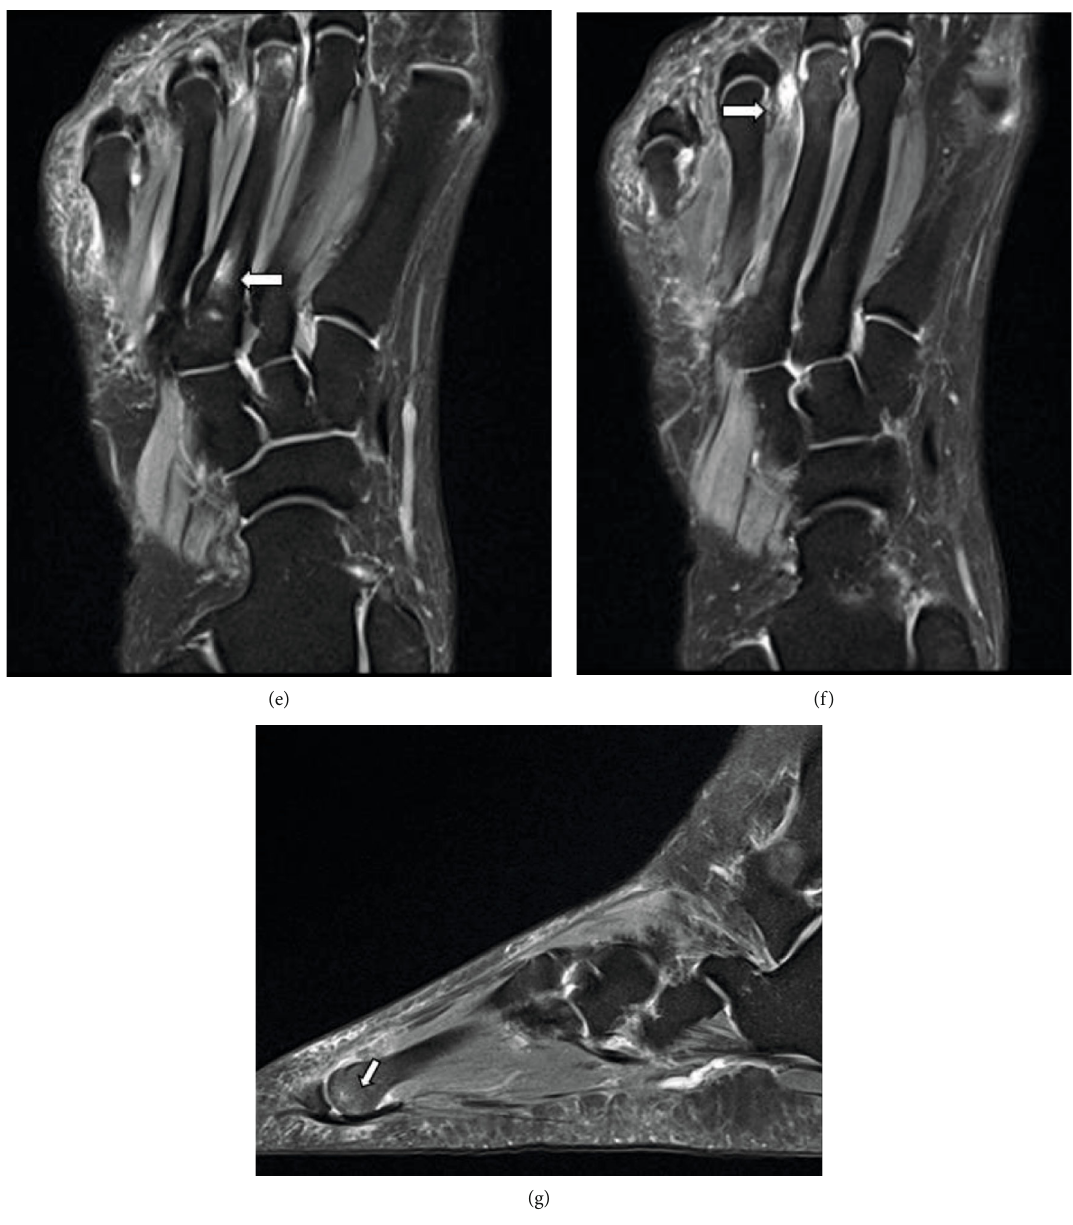
Figure 1: 40-year-old female with dorsal forefoot pain following a change in activity. AP (a) and oblique (b) radiographs reveal bony prominence of the lateral border of the proximal third metatarsal shaft. Short axis PD (c) and PDFS (d) sequences reveal abnormal articulation between the base of the third and fourth metatarsals. Surrounding reactive bony hypertrophy and intramedullary marrow oedema signal. This is consistent with nonosseous intermetatarsal coalition. Coronal PDFS (e) sequence with nonosseous coalition between the base of the third and fourth metatarsals. Localized marrow oedema signal at the third metatarsal base. Coronal PDFS (f) sequence reveals a bursal-neuroma complex at the third intermetatarsal space corresponding to the location of the coalition. Sagittal PDFS sequences (g) with low-grade marrow oedema in the third metatarsal head. These are speculated to arise from the altered weight-bearing mechanics as a result of the coalition with increased load on the metatarsal